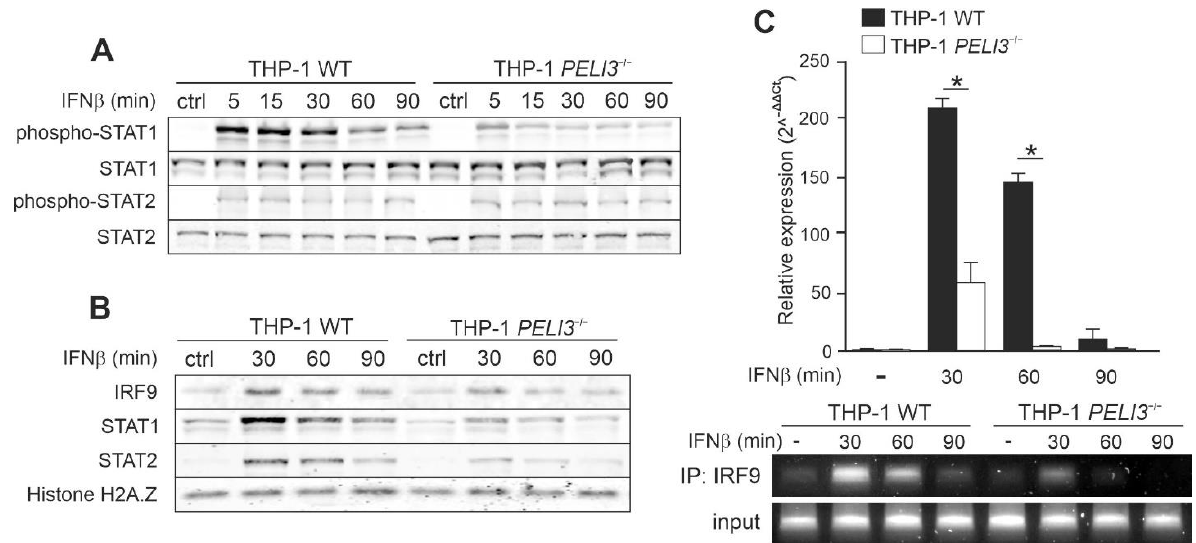
Figure 4. IFNβ/Pellino3 -dependent activation of CXCL10 is regulated by IRF9. ( A – C ) Wild type (WT) and PELI3 −/− THP- 1 cells were treated with IFNβ (1000 U /mL) for indicated time periods. Whole-cell lysates ( A ) or nuclear fraction ( B ) were subjected to SDS-PAGE followed by Western blotting. Protein detection was performed using specific antibodies and appropriate secondary antibodies conjugated to the fluorescent dye in the infrared range. Visualization was performed using the Odyssey CLx Imaging System LI-COR. The results presented are representative of at least three independent experiments. ( C ) Cells were fixed with formaldehyde, followed by nuclei isolation and sonication. Sonicated nuclear lysates were immunoprecipitated with an anti-IRF9 or rabbit IgG control antibody. Input DNA (prior to immunoprecipitation) and immunoprecipitated chromatin were analyzed by quantitative real-time PCR (2 –(ΔΔCT) ) (top) and 35 cycles of standard PCR (bottom) with primers designed to amplify an ISRE binding site in the human CXCL10 gene promoter region. Products of standard PCR were resolved on 1.5% ( w/v ) agarose gel electrophoresis. All results presented are representative of at least three independent experiments. * p ≤ 0.01 (unpaired Student’s t -test) .